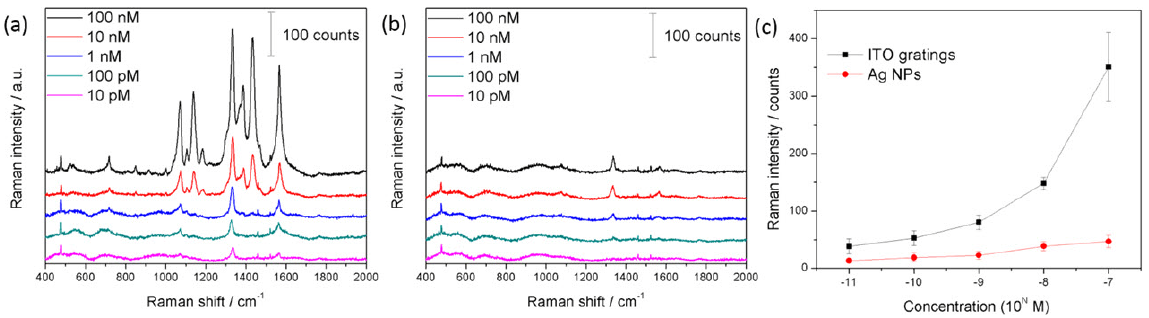
Figure 6. SERS spectra of 5,5’-dithiobis(2-nitrobenzoic acid) (DTNB) with concentrations ranging from 100 nM to 10 pM on ( a ) ITO gratings and on ( b ) bare Ag NPs; ( c ) a comparison of the Raman peaks at 1331 cm −1 .